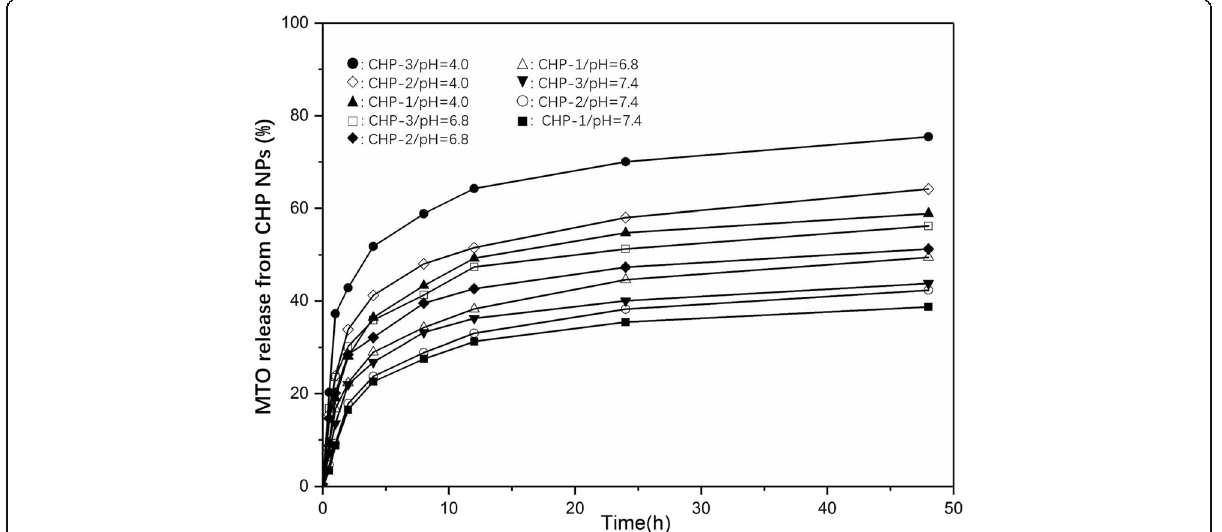
Fig. 3 Mitoxantrone (MTO) release from pullulan NPs in phosphate buffered saline (black square: CHP-1, white circle: CHP-2, black down-pointing triangle: CHP-3), in pH 6.8 (white up-pointing triangle: CHP-1, black diamond: CHP-2, white square: CHP-3) and in pH 4.0 (black triangle: CHP-1, white diamond: CHP-2, black circle: CHP-3) at 37 °C in vitro